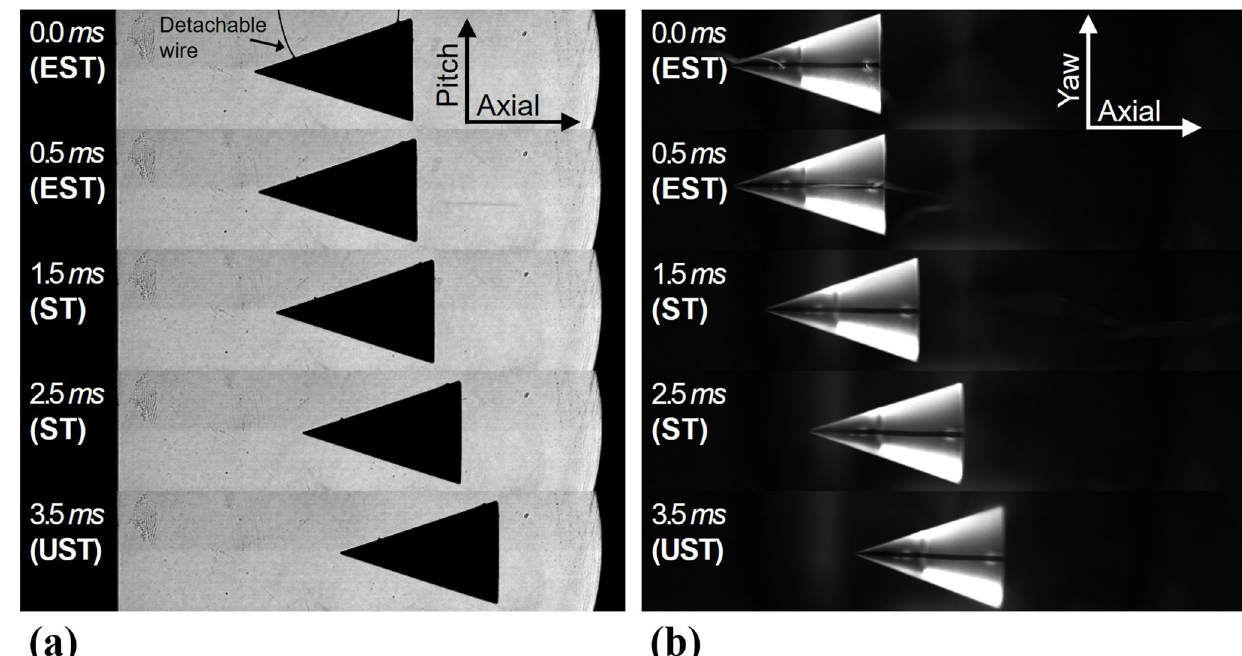
Fig 10. Captured images of the free-flying test model in the FFT. (a) Axial and Pitch directions, (b) Axial and yaw directions. https://doi.org/10.1371/journal.pone.0270743.g010 representative detection results with an interval of 0.5 ms are shown. The horizontal axis X rep- resents the axial direction and the vertical axis Y represents the pitching direction. It can be seen that the test model was moved along the axial directions over time because of the drag. A total of 80 images were used for the corner detection to obtain the cumulative displacements and the change in the angle-of-attack. In order to minimize the disturbance effects caused by